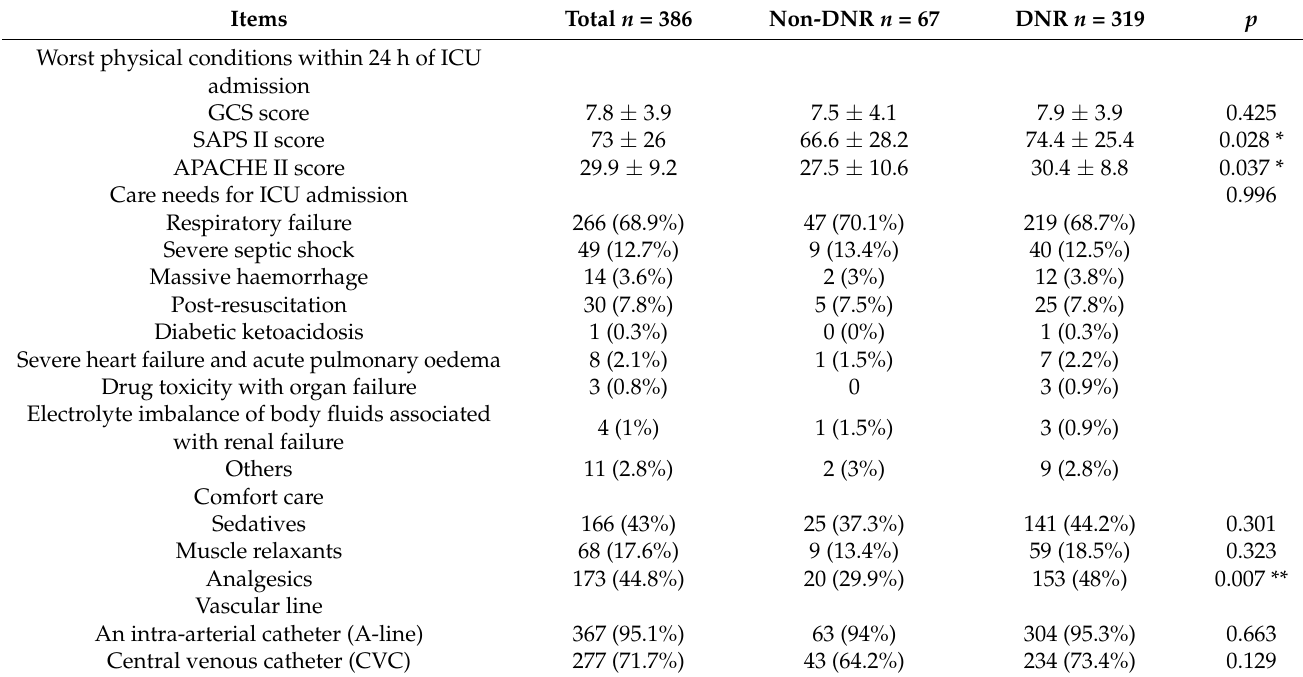
Table 2. Reasons for ICU admission, physical condition, comfort line, and comfort care comparison between the non-DNR and DNR